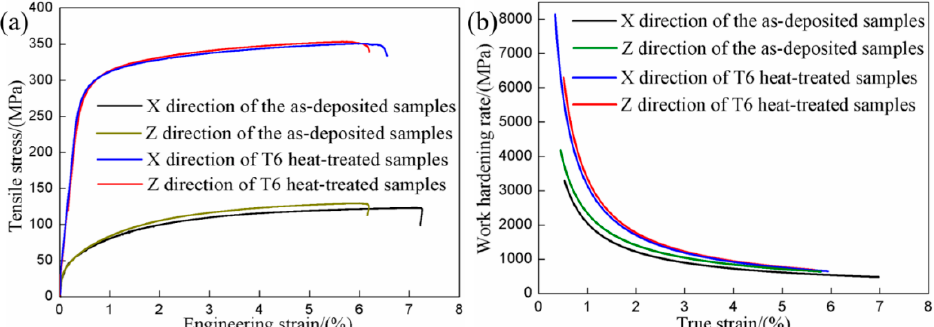
Figure 7. ( a ) Tensile test of the samples in X and Z directions fore-and-aft heat treatment; ( b )Work hardening rate plotted vs. true strain of the samples in X and Z directions fore-and-aft heat treatment. Table 2. The mechanical properties of the samples before and after heat After T6 heat treatment, the elasticity modulus (m E) , the yield strength (R p0.2 ) and the ultimate tensile strength (R m) of the samples in X direction has an increase of 37.79%, 272.46% and 181.22% respectively, and those in Z direction increases 41.97%, 318.37% and 171.41%, respectively. The elongation (A) of the samples in X direction has a decrease by 7.49%, while that in Z direction is